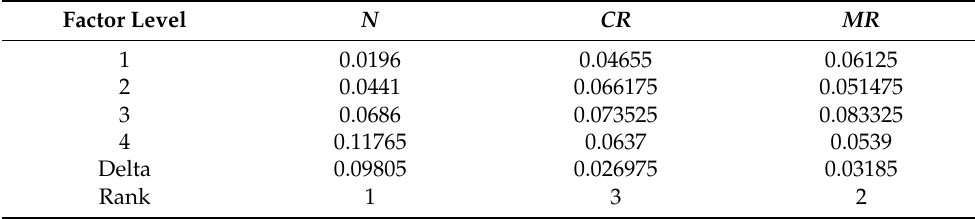
Table 3. Response